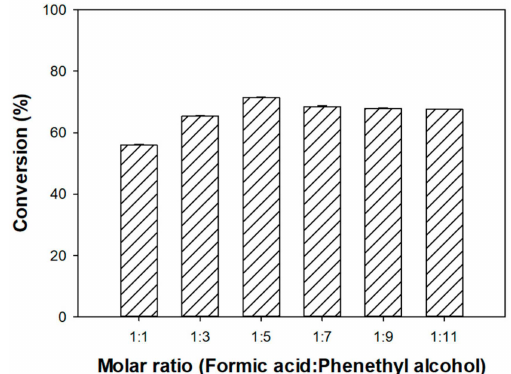
Figure 3. E ff ect of formic acid:phenethyl alcohol molar ratio on the Novozym 435-catalyzed synthesis of phenethyl formate. The conversion yield (%) was calculated by GC